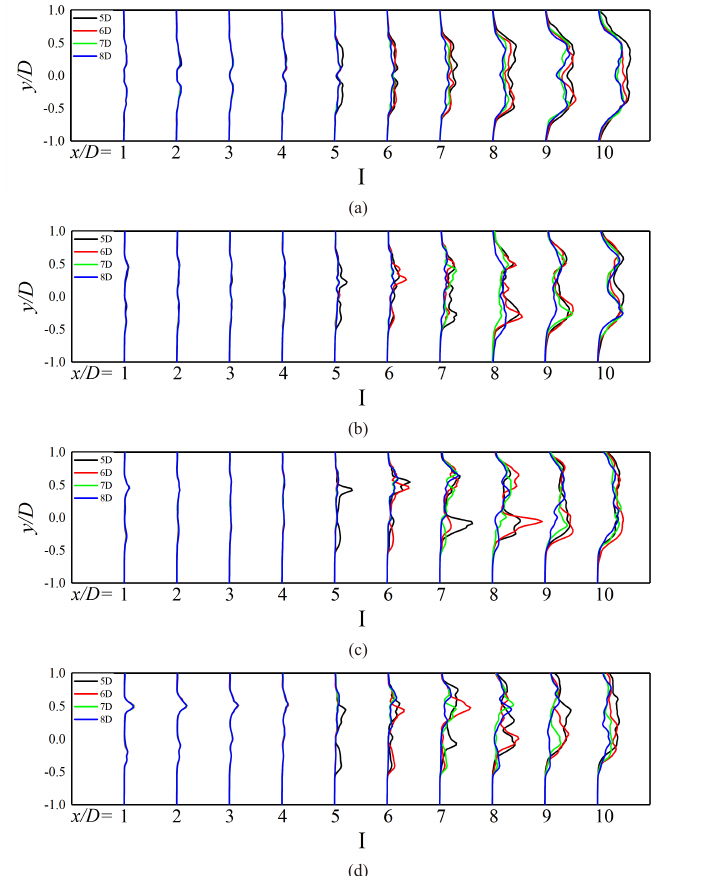
Figure 13. Time − averaged turbulence intensity profiles. The turbulence intensity scale for each profile ranges from 0 to 0.5. Each consecutive profile is taken 1D downwind: ( a ) yaw = 0 ◦ ; ( b ) yaw = 10 ◦ ; ( c ) yaw = 20 ◦ ; ( d ) yaw = 30 ◦